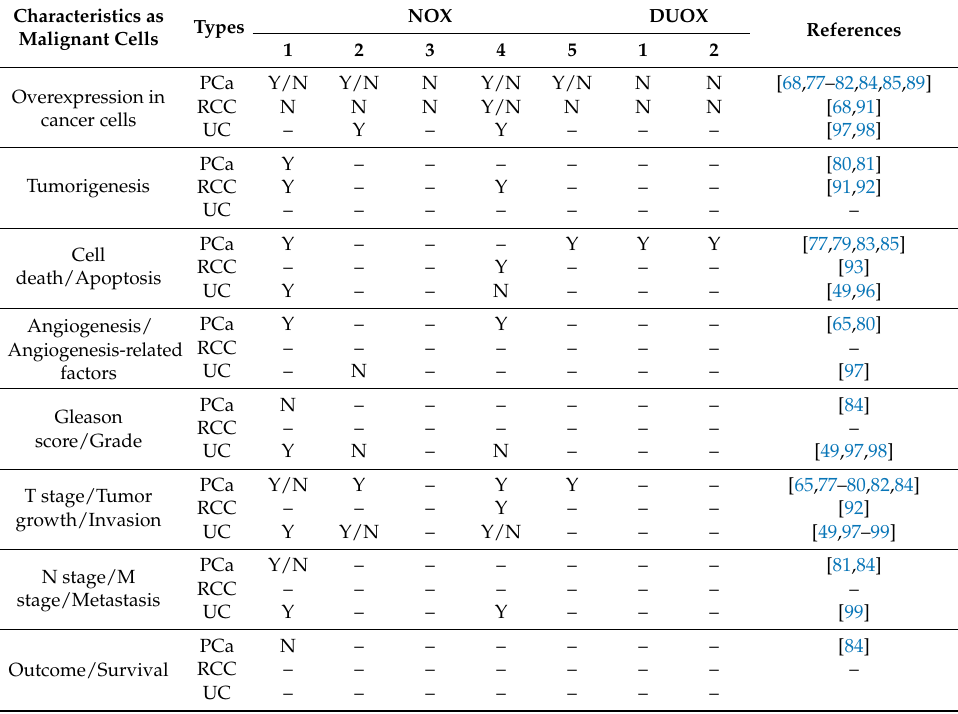
Table 1. Summary of pathological roles of NOXs in urological